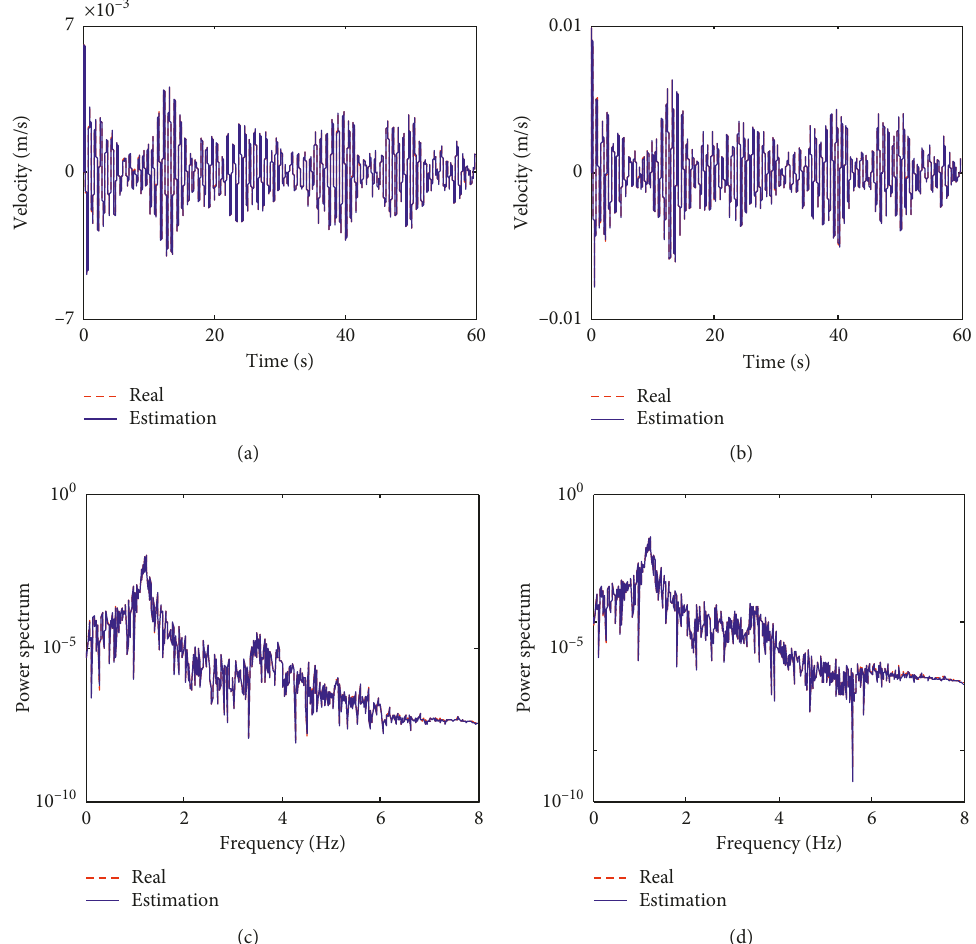
Figure 4: Comparison of the structural velocity responses for time and frequency domains. Time vs velocity on the (a) fifth floor and (b) tenth floor. Frequency vs power spectrum on the (c) fifth floor and (d) tenth